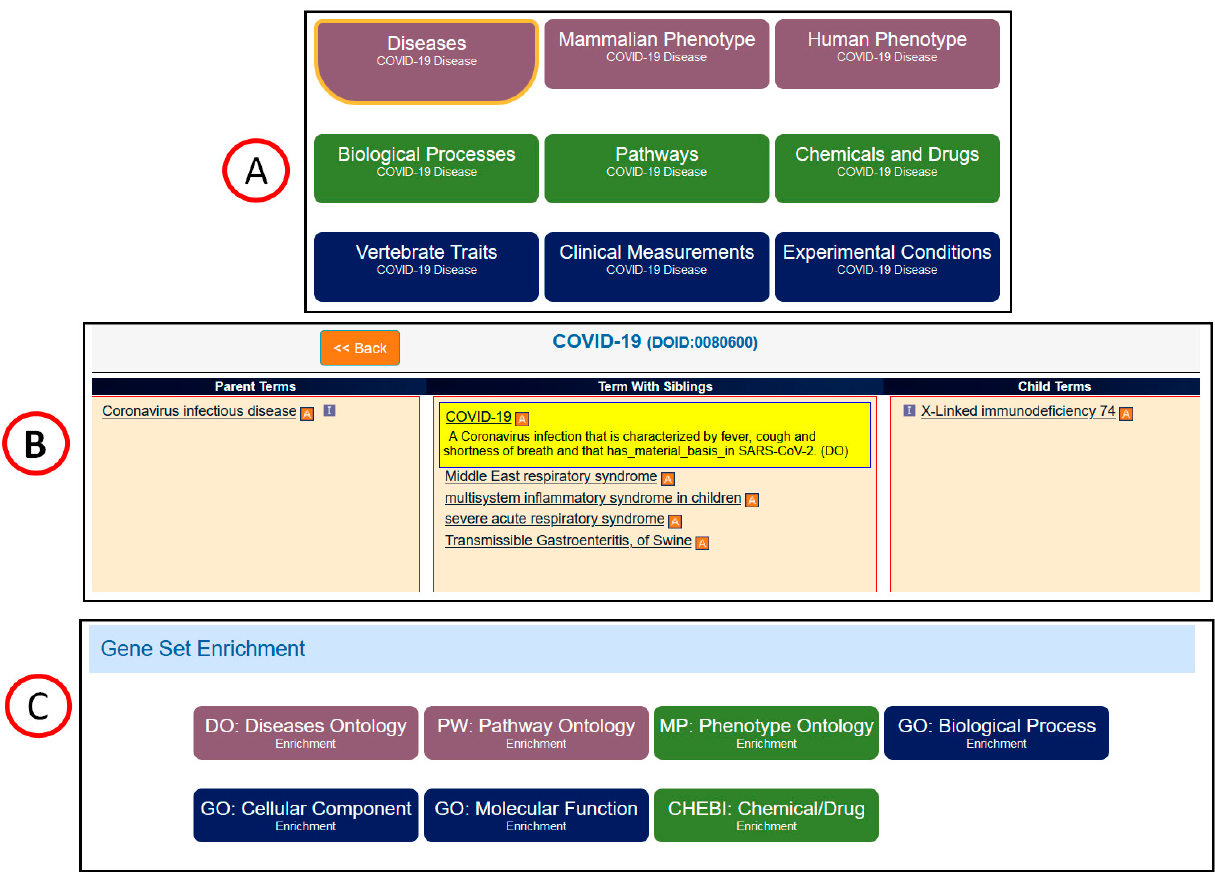
Figure 1. The COVID-19 Disease Portal landing page. ( A ). Annotations made to COVID-19 genes are organized into nine categories displayed in the COVID-19 Disease Portal. ( B ). The customized disease ontology browser showing terms associated with COVID-19 disease genes is shown at the middle. ( C ). Seven ontology enrichment analyses allow users to send COVID-19 disease genes to the MOET tool for gene set enrichment analysis.